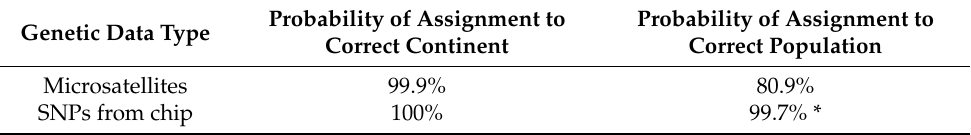
Table 2. Probabilities of correctly assigning an individual Aedes aegypti to its population of origin using either microsatellite variation or ~16,000 SNPs from a chip. From [48]. Probability of Assignment Probability of Assignment to Genetic Data Type to Correct Continent Correct Population Microsatellites 99.9% 80.9% SNPs from chip 100% 99.7% *